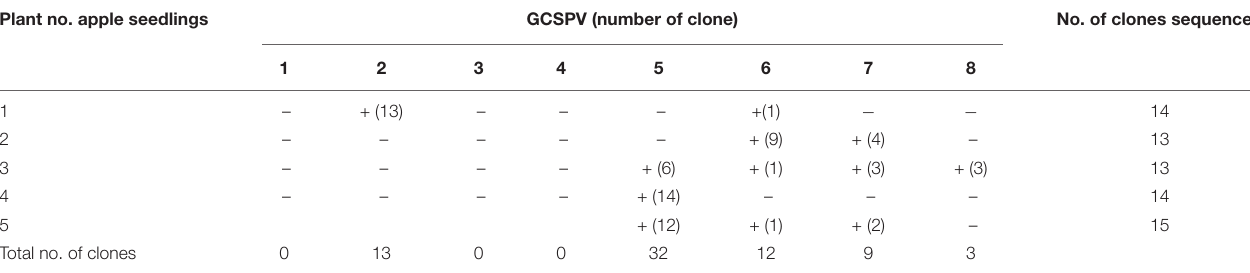
TABLE 4 | Analysis of the sequence variants (GCSPVs) of ASPV found in leaves of apple seedlings (No. 1 ∼ No. 5) inoculated with ASPV-RNA transcripts and ALSV-AtFT/MdTFL1. Plant no. apple seedlings GCSPV (number of